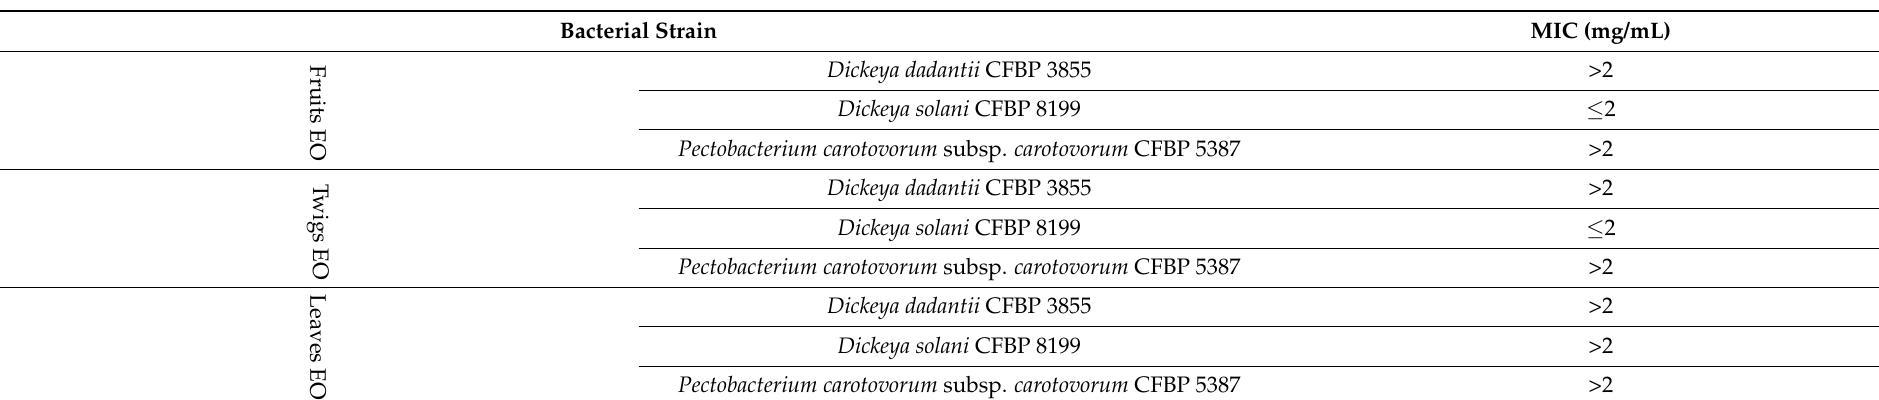
Table 3. The minimum inhibitory concentration of Eucalyptus gunnii essential oils against the tested bacterial